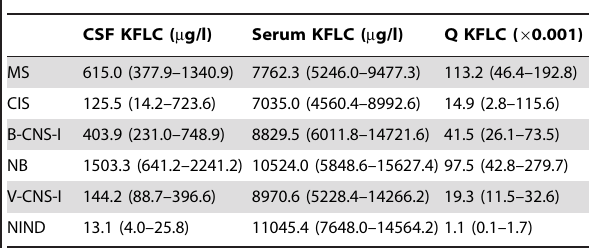
Table 2. KFLC in CSF and serum.